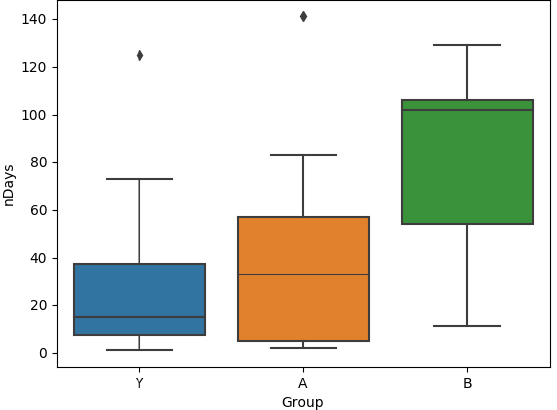
Figure 7. Box plots for number of days with 2 or more sessions for each group (Note: Y-axis not aligned with the previous plot).